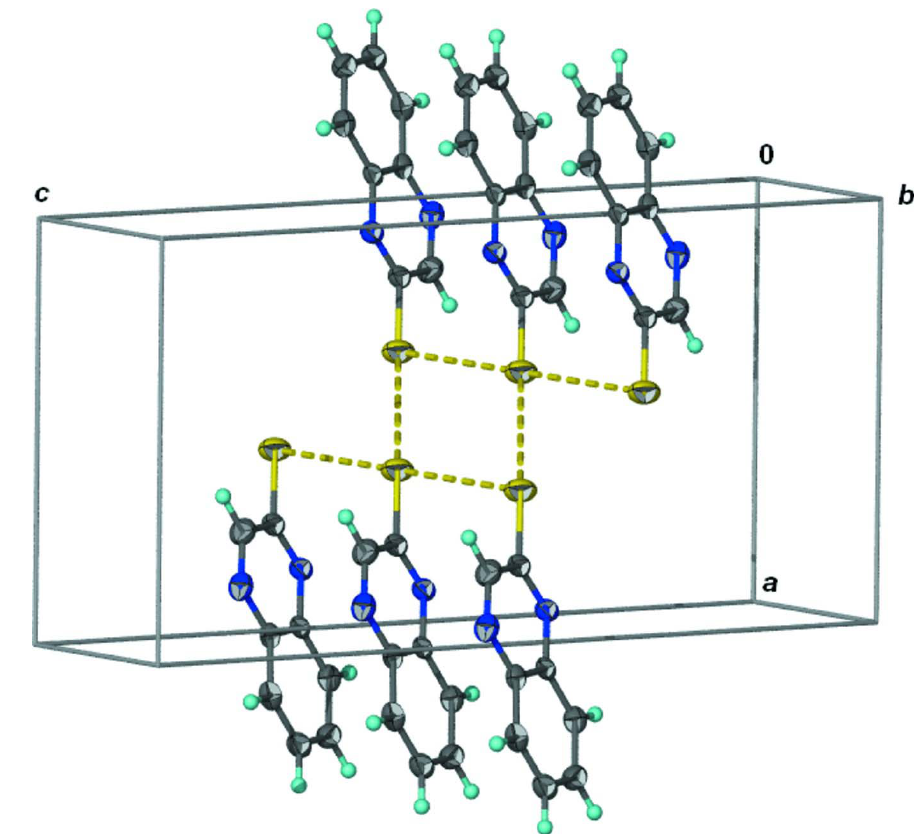
Figure 2 Chain structure in C